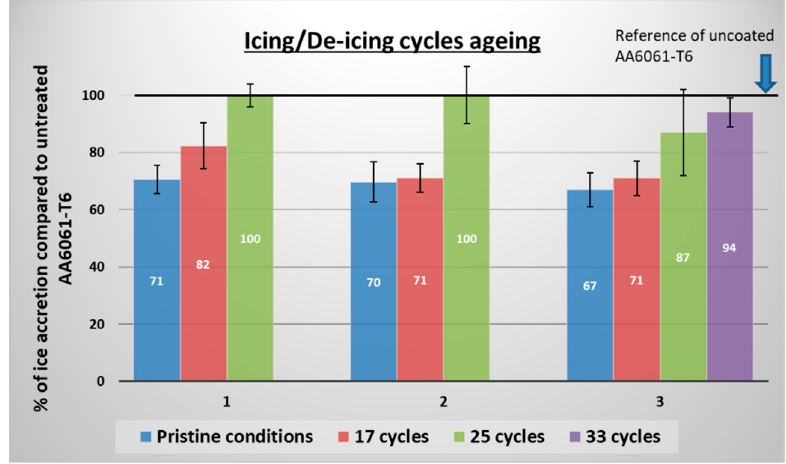
Figure 7. Evolution of ice accretion along the icing/de-icing cycles.